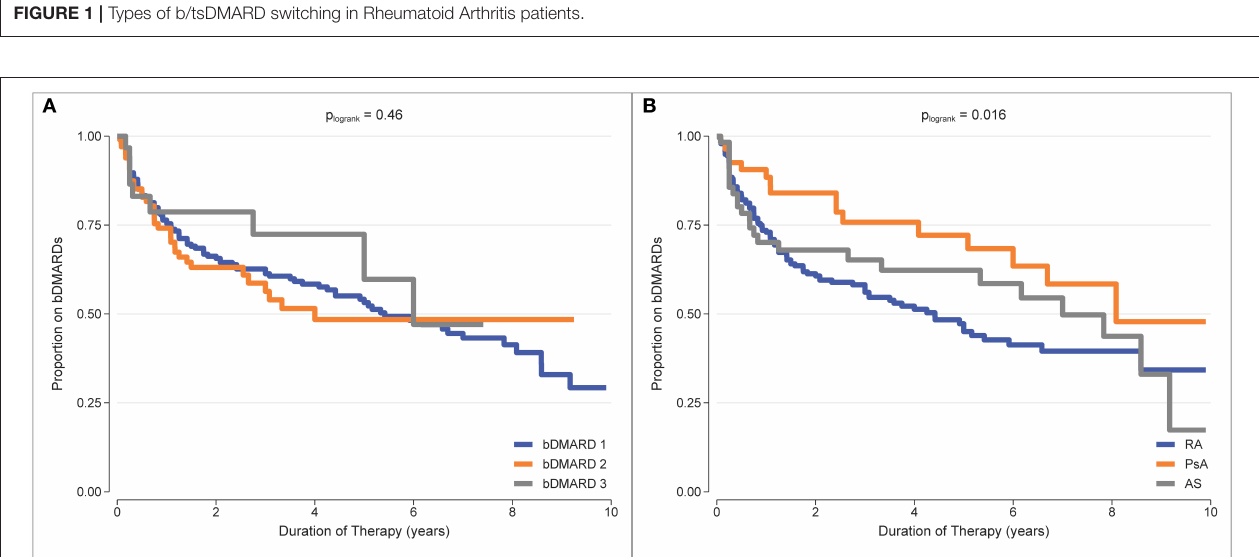
FIGURE 1 | Types of b/tsDMARD switching in Rheumatoid Arthritis patients.